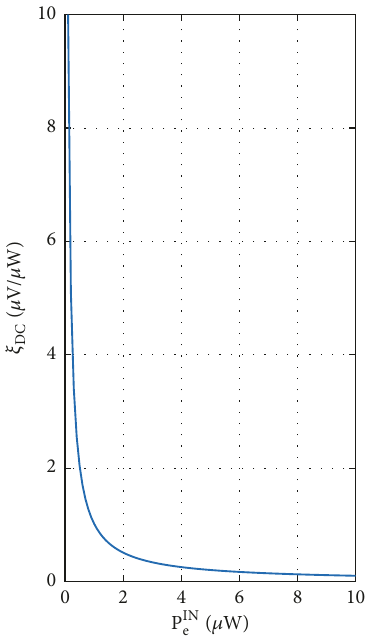
Figure 5: Dependence of the thermal contribution to microwave sensitivity of the spin-torque diode on the microwave input power at the a.c. current frequency of 10 Figure 4: Frequencydependenceof theamplitude of rectified signal 𝑉 𝐷𝐶 generated across the MTJ caused by microwave heating of the spin-torque diode at different values of the input microwave power 𝑃 𝐼𝑁 𝐵 = 50𝑚𝑇 , where the parameters of MTJ 𝑒 and the magnetic field were taken from [14, 21] and the temperature 𝑇 0 is equal to 300 K.